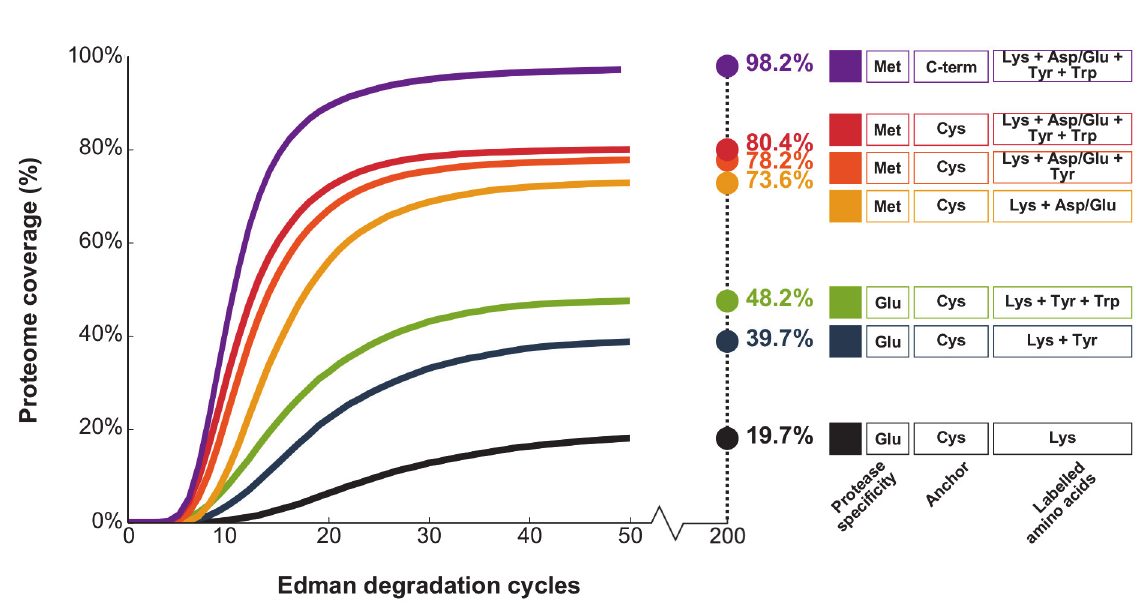
Fig 2. Simulations of ideal experimental conditions suggest relatively simple labeling schemes are sufficient to identify most proteins in the human proteome. Each curve summarizes the fraction of human proteins uniquely identified by at least one peptide as a function of the number of sequential experimental cycles (a paired Edman degradation reaction and TIRF observation). Here, we consider peptides generated by different proteases ( e . g . Glu represents cleavage C-terminal to glutamic acid residues by GluC, Met represents cleavage after methionine residues by cyanogen bromide) and under different labeling schemes ( e . g . Lys + Tyr indicates Lys and Tyr selectively labeled with two distinguishable fluorophores. Asp/Glu indicates both residues are labeled with identical fluorophores). Peptides are immobilized as indicated, with Cys representing anchoring by cysteines (thus, only cysteine- containing peptides are sequenced) and C-term representing anchoring by C-terminal amino acids. Increasing the number of distinct label types improves identification up to 80% within only 20 experimental cycles even when only Cys-containing peptides are sequenced; near total proteome coverage is theoretically achievable when cyanogen bromide generated peptides are anchored by their C-termini and labeled by a combination of four different fluorophores. Cycle numbers denote upper bounds, since each fluorosequence is not allowed to proceed past the anchoring residue (cysteine or C- terminus). Note also that the peptide length distributions change depending on the enzyme used for cleavage, with median lengths of 26 amino acids for cyanogen bromide, 8 for GluC and 10 for trypsin